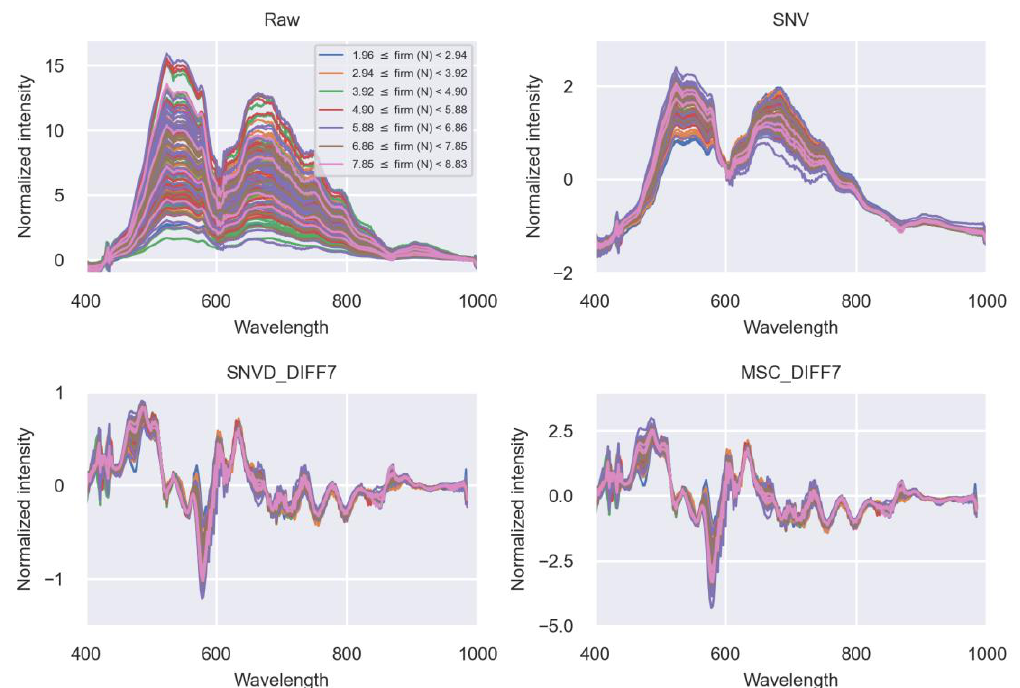
Figure 8. Average spectra of cell walls per blueberry among different firmness with three different preprocessing methods, Raw ( top-left ), SNV ( top-right ), SNVD-DIFF7 ( bottom-left ), and MSC-DIFF7 ( bottom-right ).